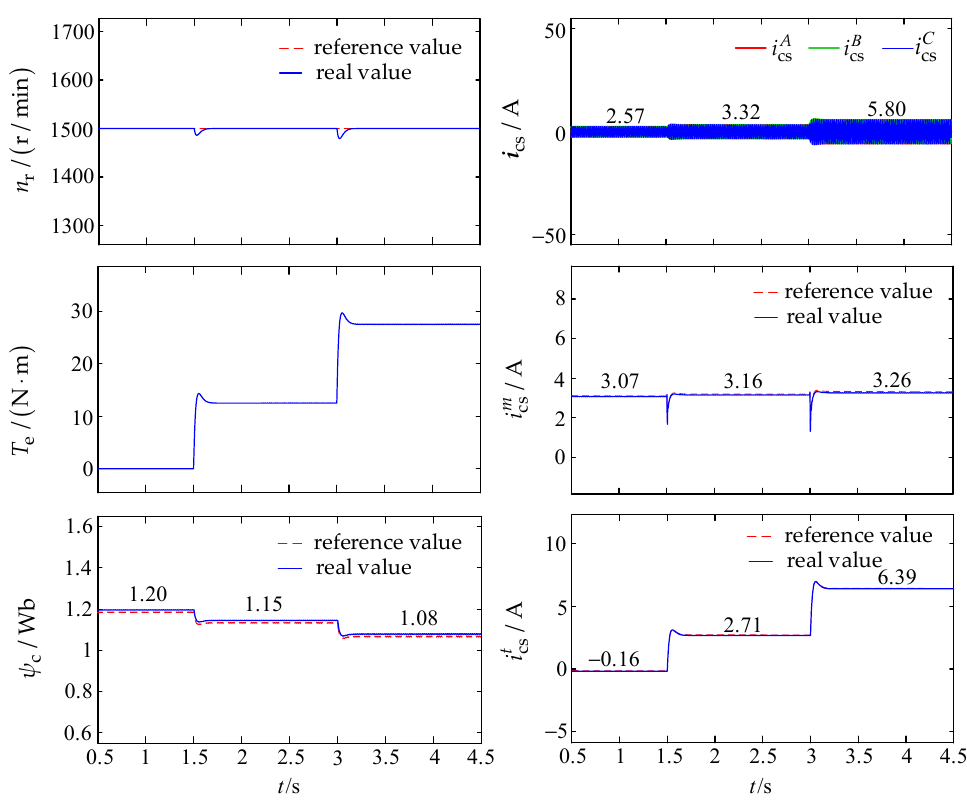
Figure 17. Simulation results of robustness verification of MTPA control when the torque changes.